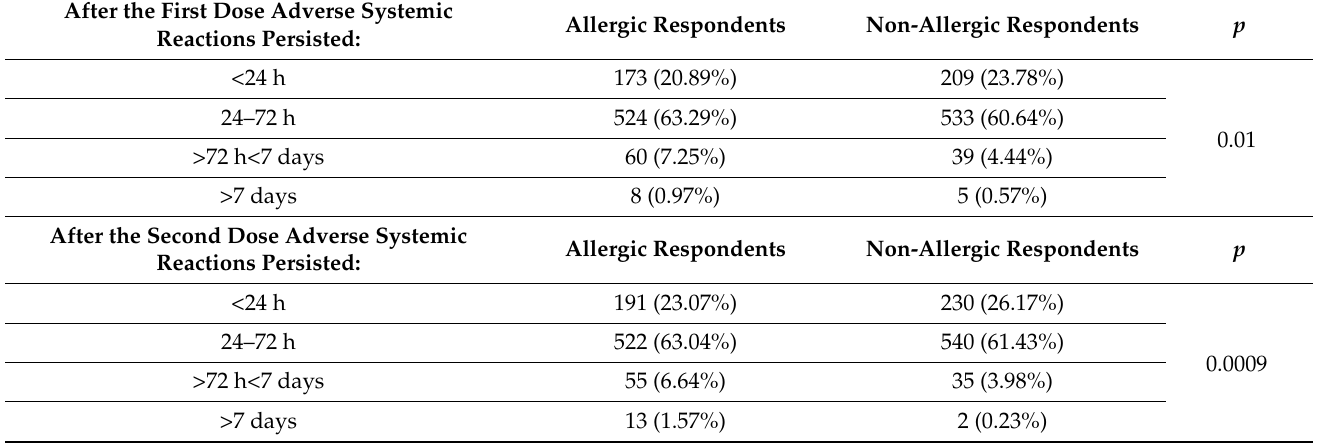
Table 4. Duration of systemic adverse symptoms in individuals receiving Pfizer-BioNTech anti COVID-19 vaccine. After the First Dose Adverse